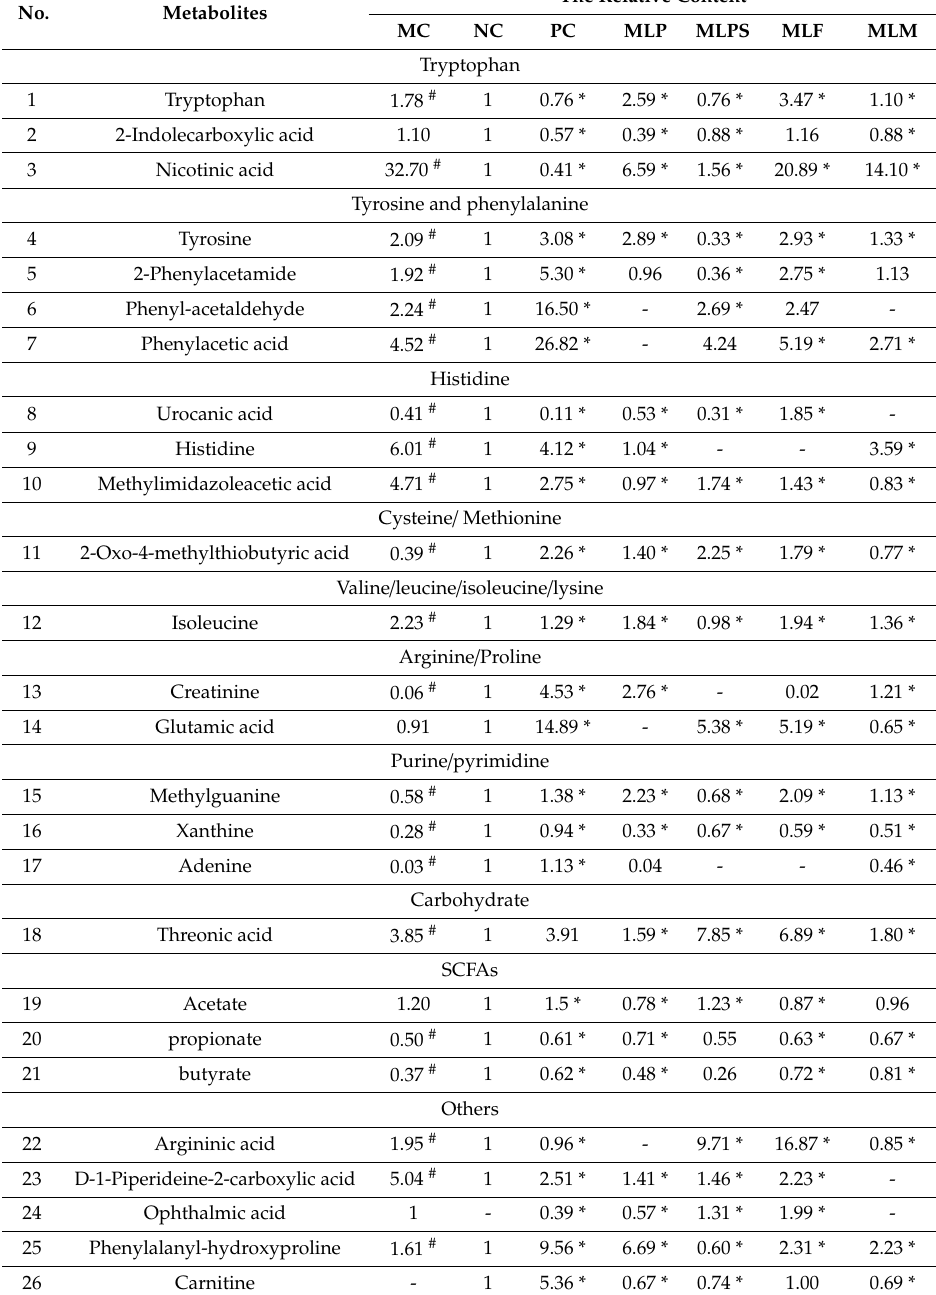
Table 5. Representative and main di ff erentiated fecal metabolites derived from mammalian-gut microbial co-metabolism among di ff erent groups analyzed by UPLC-Triple-TOF-MS and GC-MS.